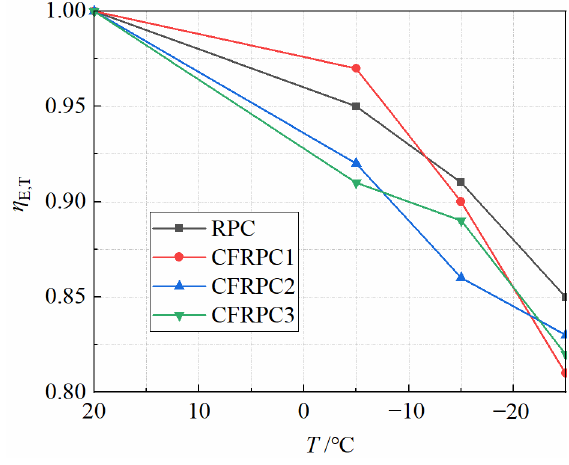
Figure 21. Relationship η E,T vs. T.